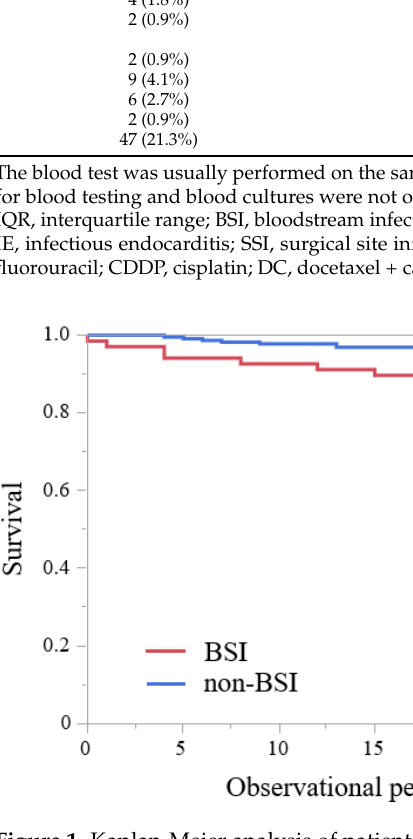
Figure 1. Kaplan-Meier analysis of patients with head and neck cancer. p = 0.450 (log rank test). BSI, bloodstream infection. Table 4. Incidence of causative pathogens